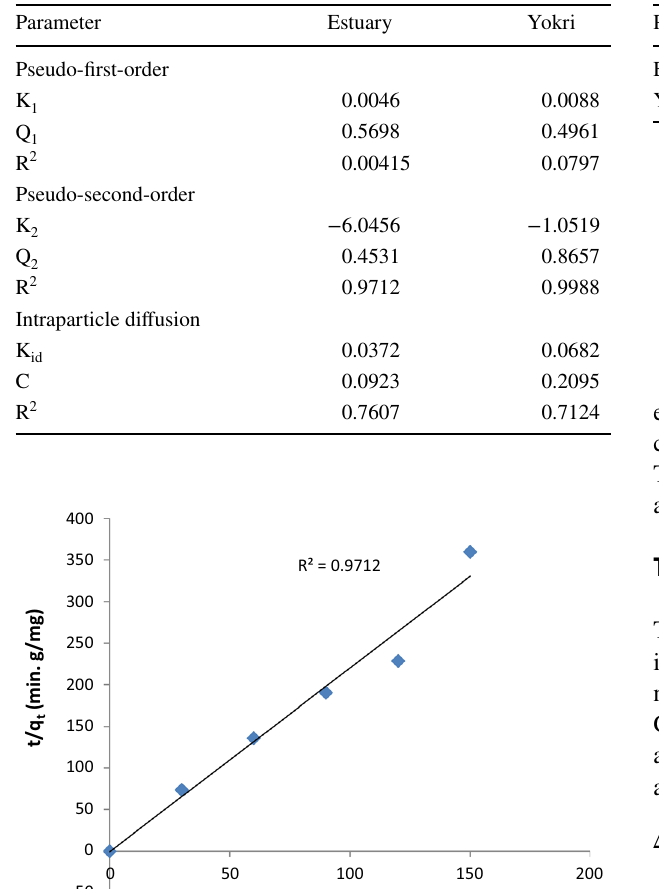
Table 4 Thermodynamic parameters for sorption of crude oils